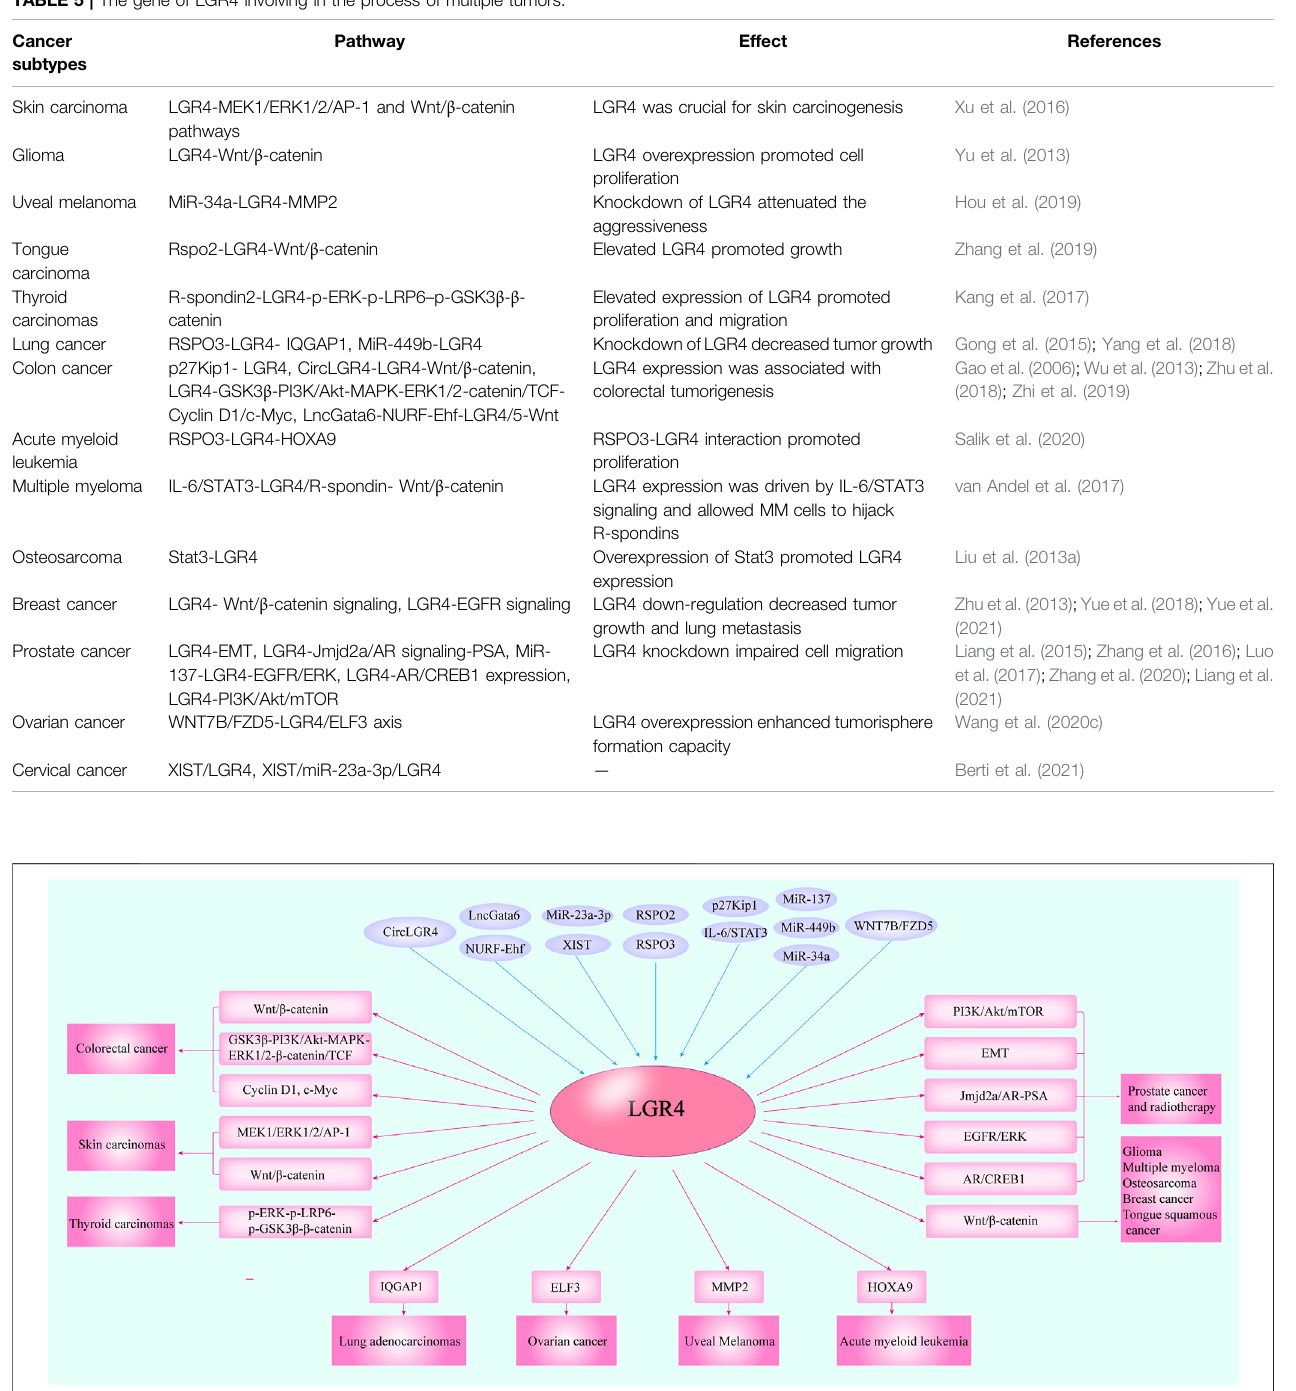
Frontiers in Genetics |